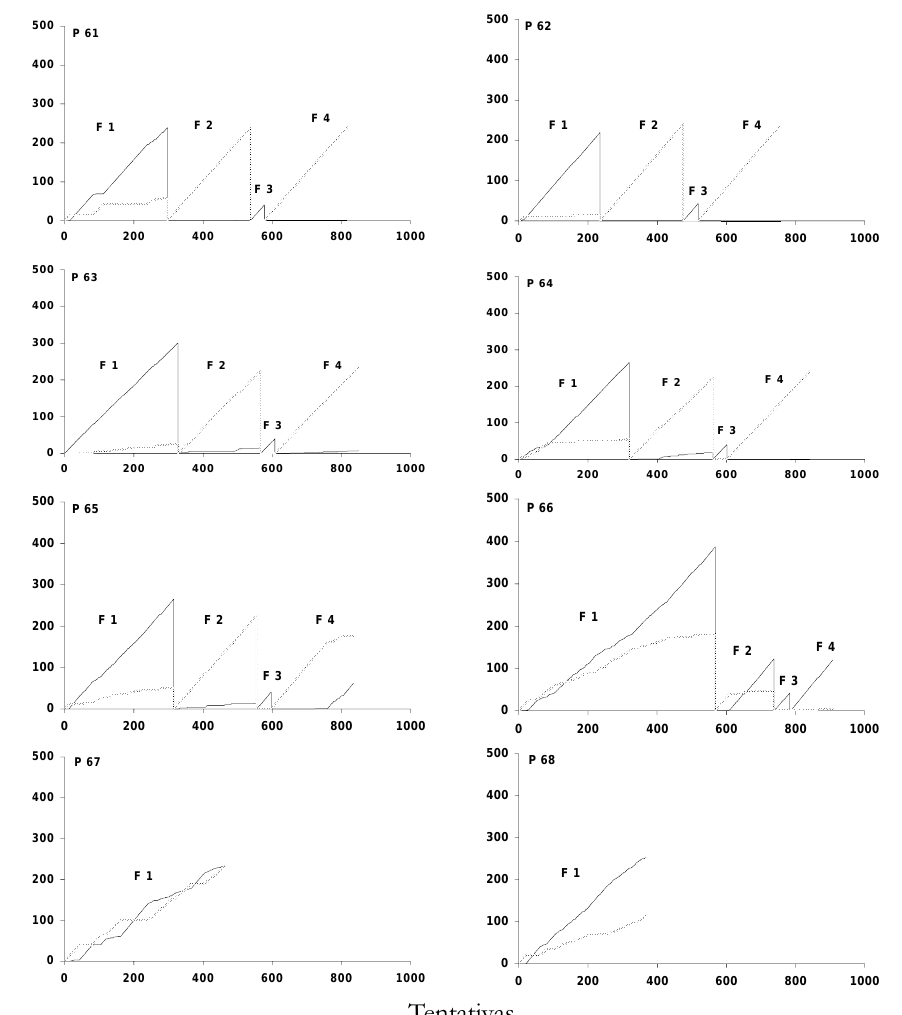
Figura 2. Freq(cid:252)Œncia acumulada de seq(cid:252)Œncias de respostas corretas (linha s(cid:243)lida preta) e incorretas (linha tracejada cinza), para cada participante (P), durante cada fase (F) experimental. Quebras na curva acumulada indicam mudan(cid:231)as de fase. Na Fase 1 a seq(cid:252)Œncia correta (refor(cid:231)ada) era estabelecida por refor(cid:231)o diferencial. Concorrentemente com a seq(cid:252)Œncia estabelecida na Fase 1 (correta em todas as fases), nas Fases 2 e 4 a regra discrepante especificava uma seq(cid:252)Œncia incorreta e na Fase 3 a regra correspondente especificava uma seq(cid:252)Œncia tambØm correta. Psicologia: Reflexªo e Cr(cid:237)tica, 2004, 17(3),